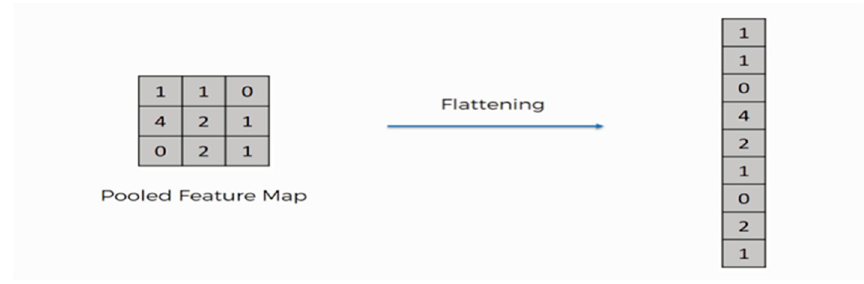
Figure 18. Flattening the pooled feature map [57].